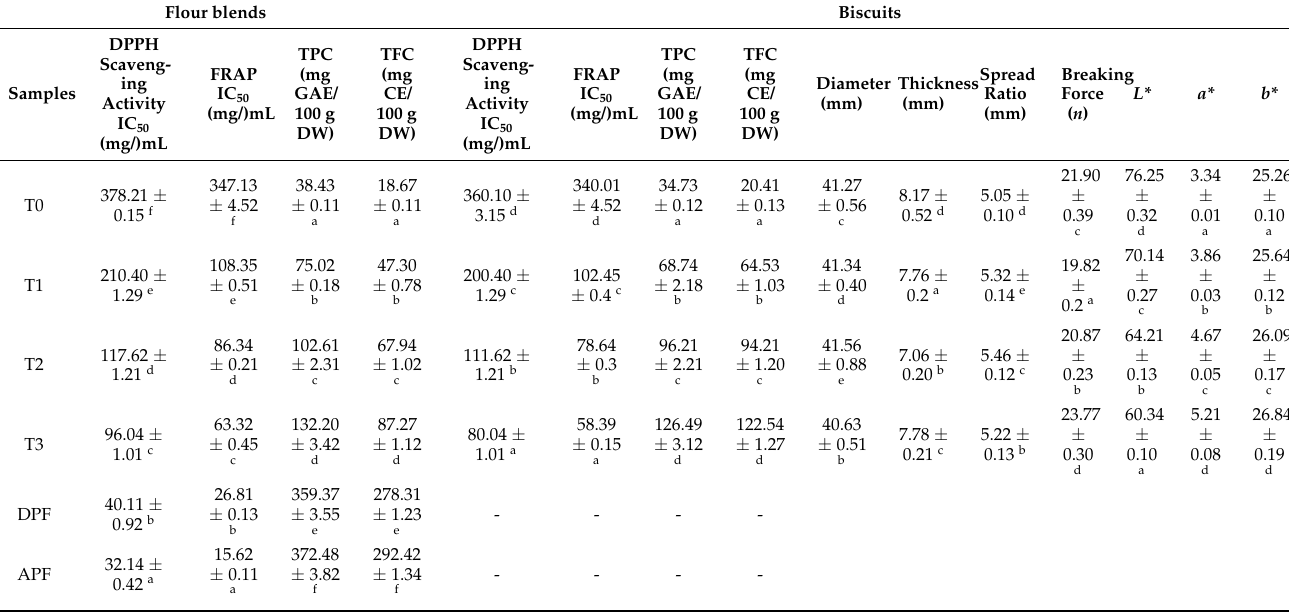
Table 4. DPPH radical scavenging activity; ferric/ferricyanide (Fe 3+ ) reducing antioxidant power (FRAP); total phenolic content (TPC); total flavonoid content (TFC); and dimension, texture, and color values of different quantities of date pit flour (DPF) and Assyrian plum flour (APF) incorporated in flour blends and their gluten-free biscuit